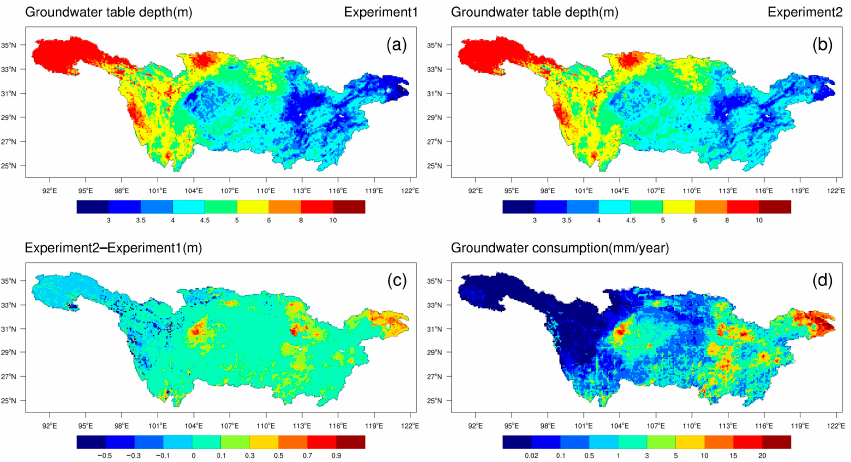
Figure 8. Spatial distribution of groundwater consumption, groundwater table depth and its variation. ( a ) is groundwater table depth for experiment1. ( b ) is groundwater table depth for experiment2. ( c ) is the difference of groundwater table depth between experiment1 and experiment2. ( d ) is mean annual groundwater consumption.